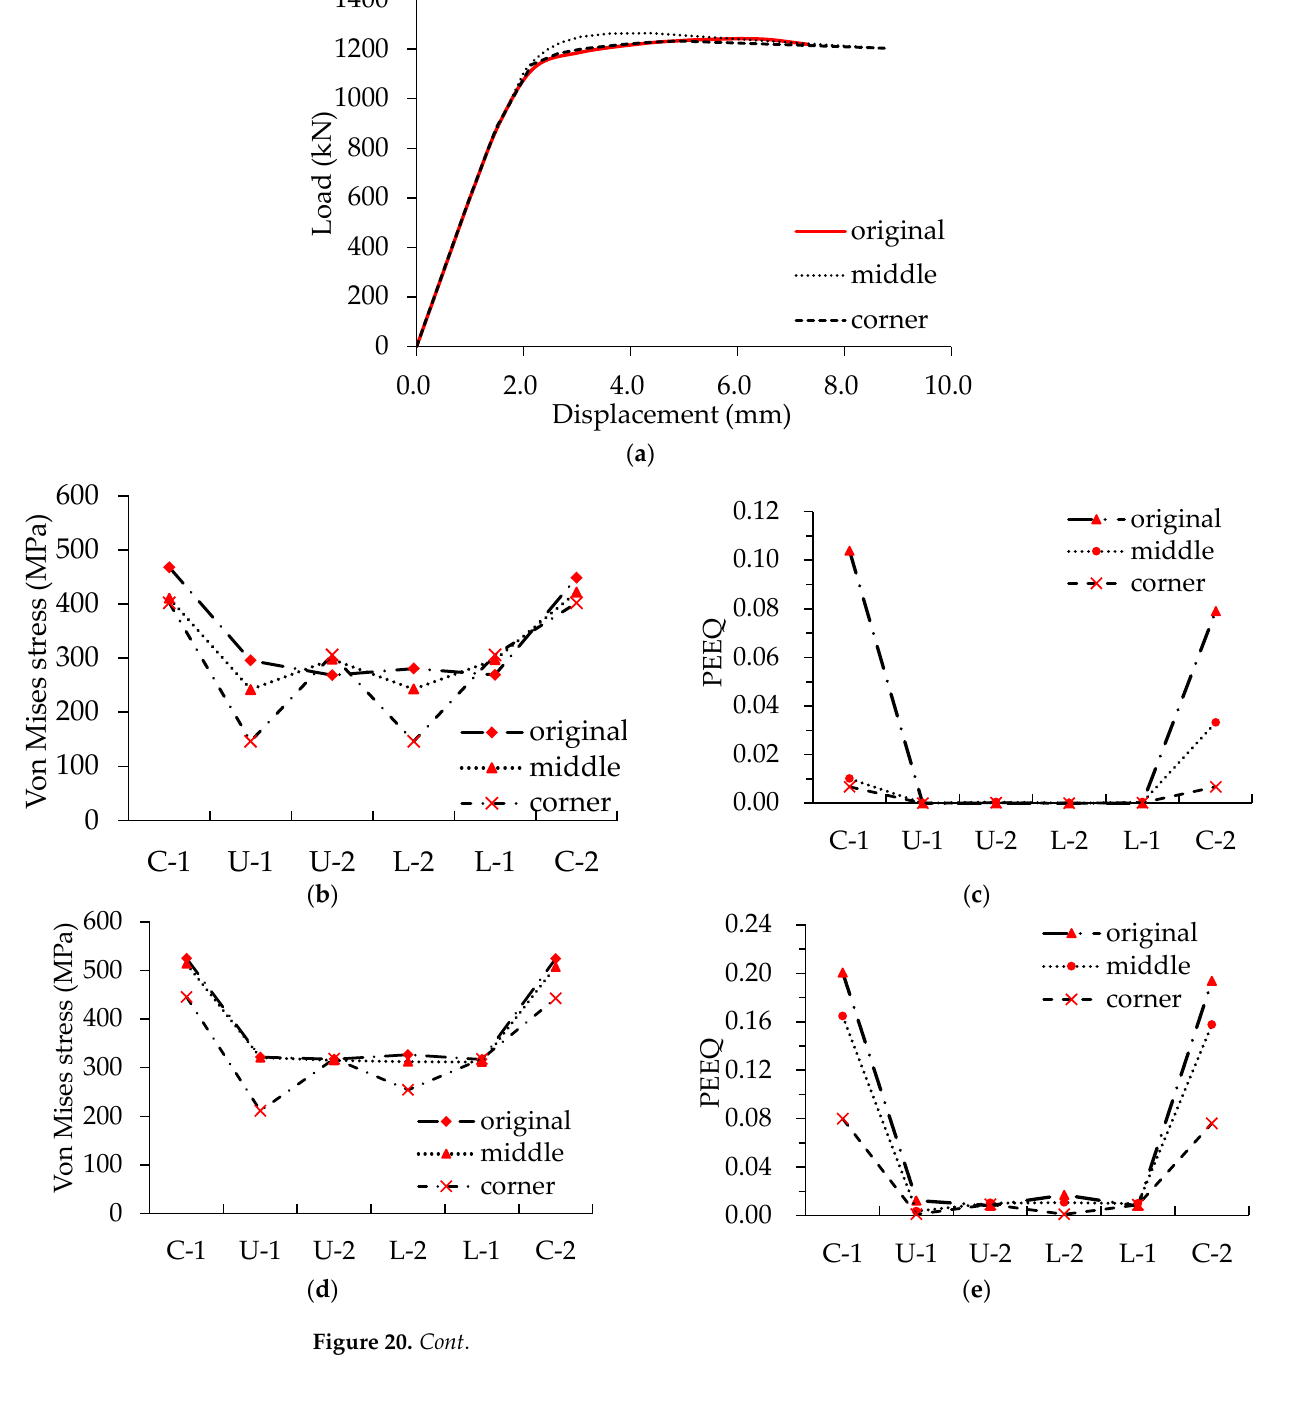
( b ) reference points of column location in middle of the corner fitting; and ( c ) reference points of column location in corner of the corner fitting.